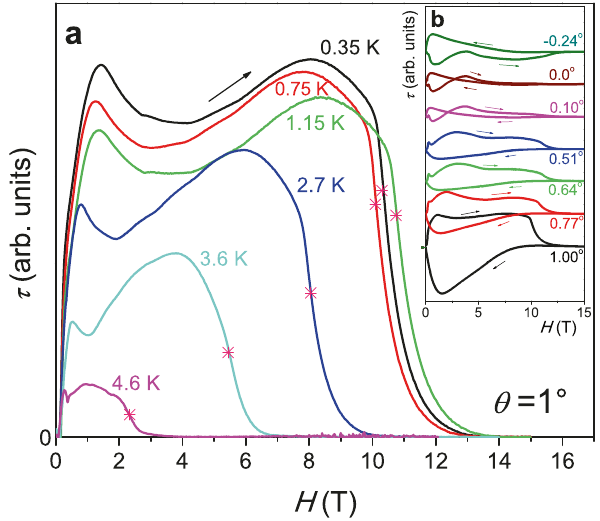
Fig. 1 Magnetic torque data in a slightly tilted fi eld of NbS 2 . a Magnetic torque magnitude τ ( H ) of NbS 2 , measured at fi xed temperatures as a function of the applied magnetic fi eld H , oriented with a small angle θ = 1° to the basal plane. The data were measured at increasing fi eld. Crosses mark the points where the steepest slope occurs near H c2 . b Magnetic torque measured at T = 0.35 K at various angles near θ = 0° (parallel fi eld). A weak linear normal state contribution was removed from all data and offsets were added for better